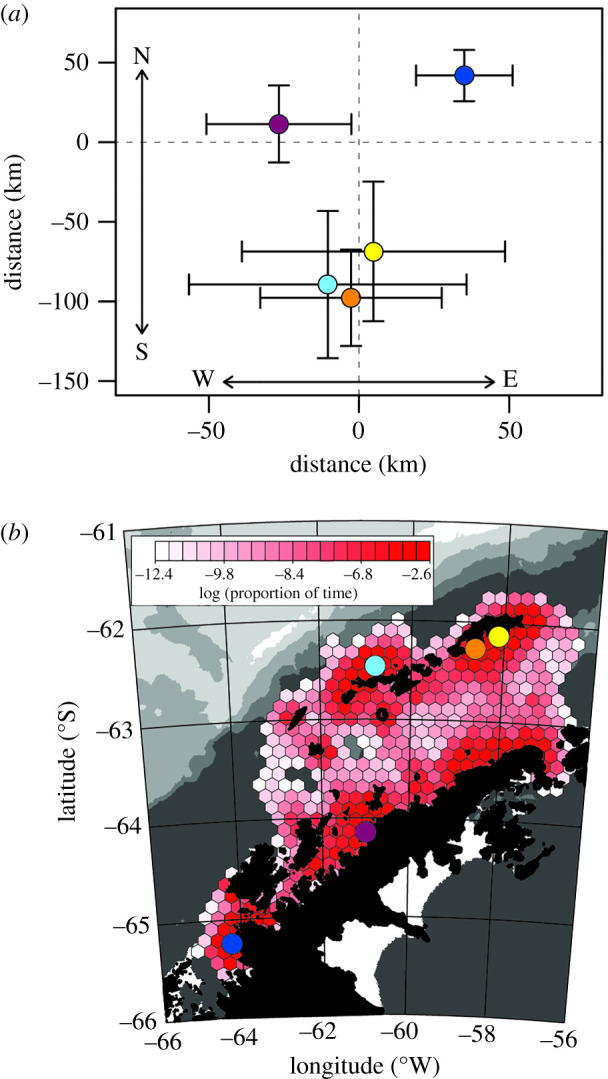
(a) Mean and 95% confidence intervals for positional shifts for birds from the Argentine Islands (dark blue), Cierva Cove (purple), Cape Shirreff (light blue), Stranger Point (orange) and Lions Rump (yellow). (b) HUDs for all tracked birds. Colony locations are indicated with circles coloured to match panel (a).